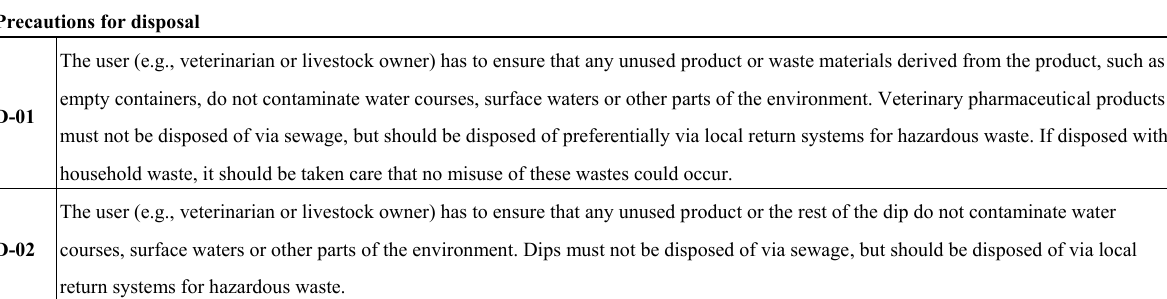
Table 2. Catalogue of proposed appropriate and effective risk mitigation